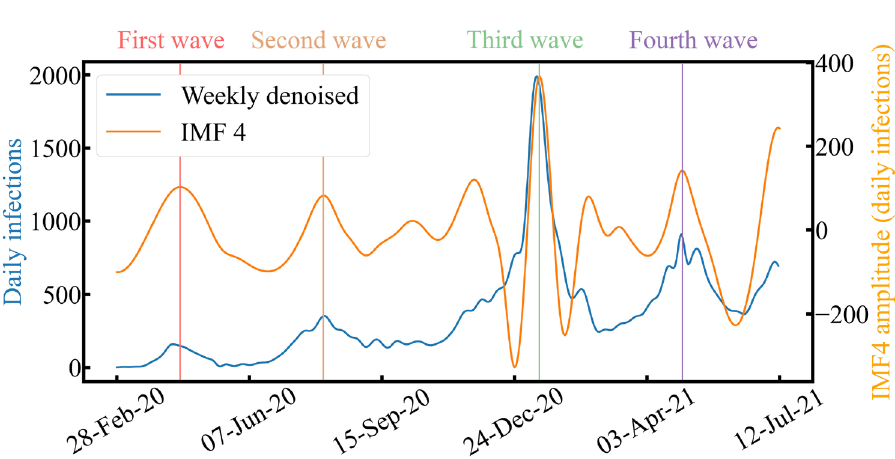
Figure 8. Comparison between the weekly denoised trend and decomposed IMF 4 . Vertical lines indicate the four